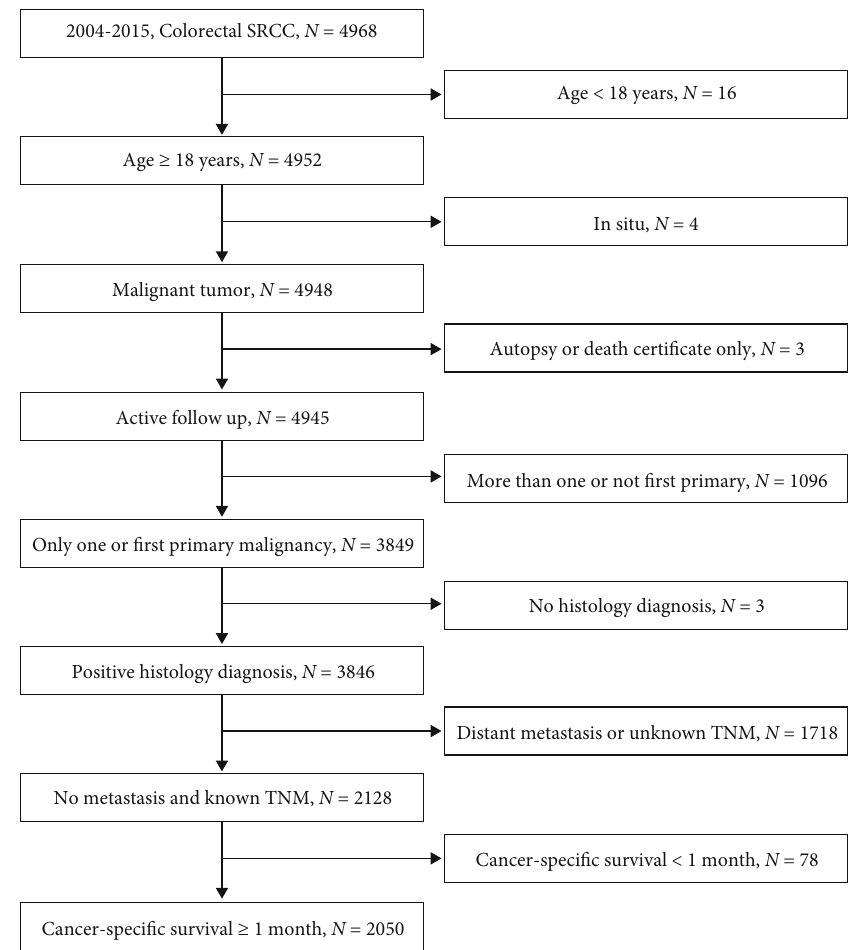
Figure 1: Flow chart of patient selection based on inclusion and exclusion